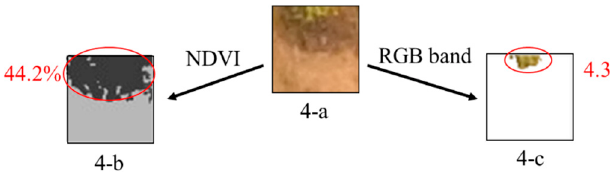
Figure 4. The classification process of one image when constructing dataset ( a ) is a UAV image, ( b ) is a vegetation image extracted through NDVI, and ( c ) is a green vegetation image extracted through RGB).